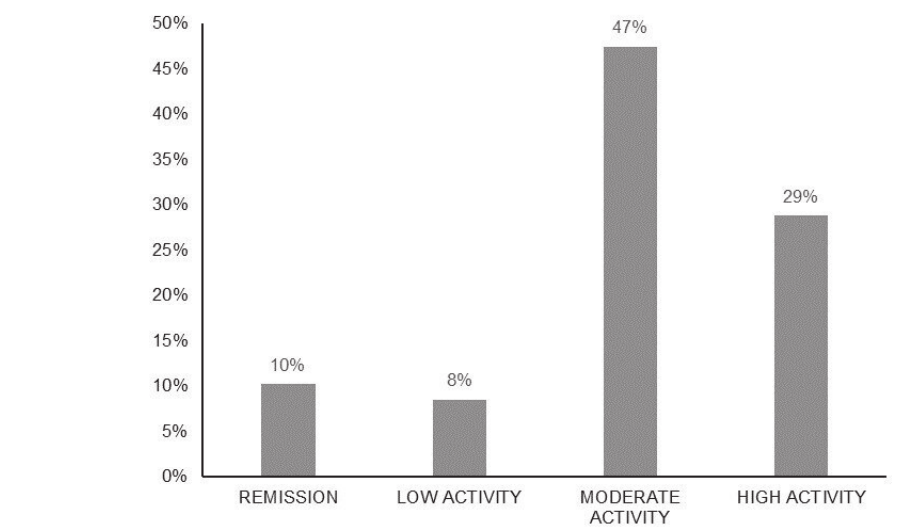
FIGURE 1 - Frequency of DAS28 results